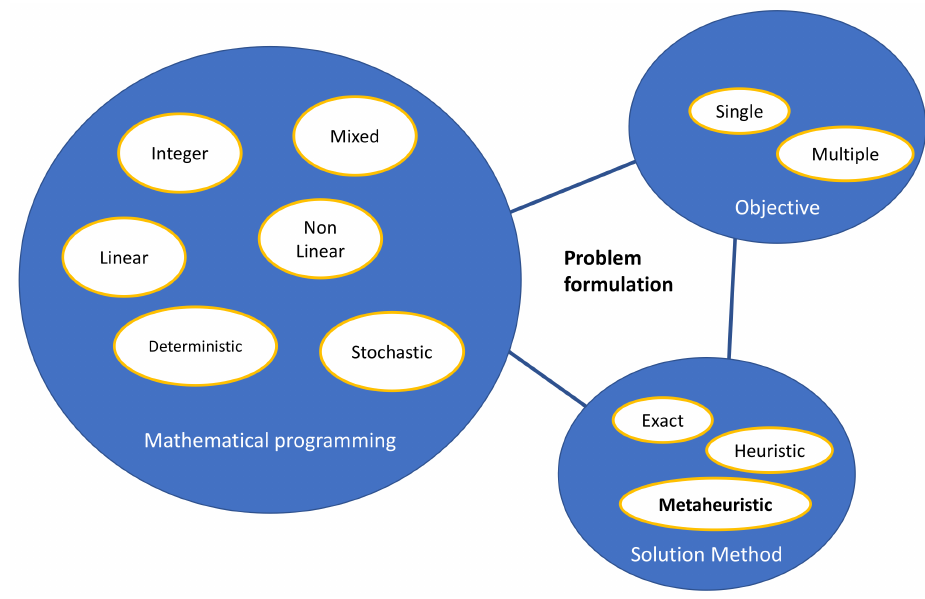
Figure 4. Model formulation classification of